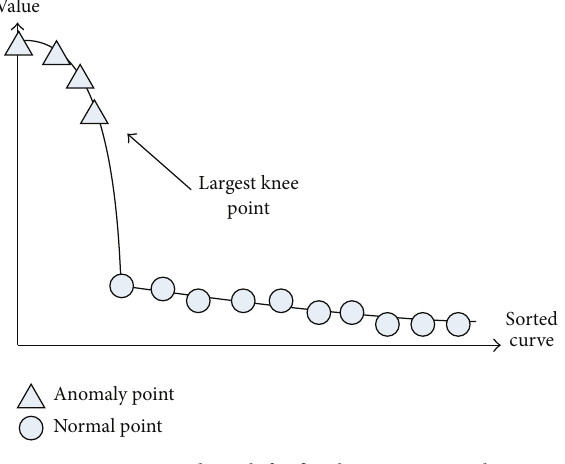
Figure 1: Sorted graph for first knee point